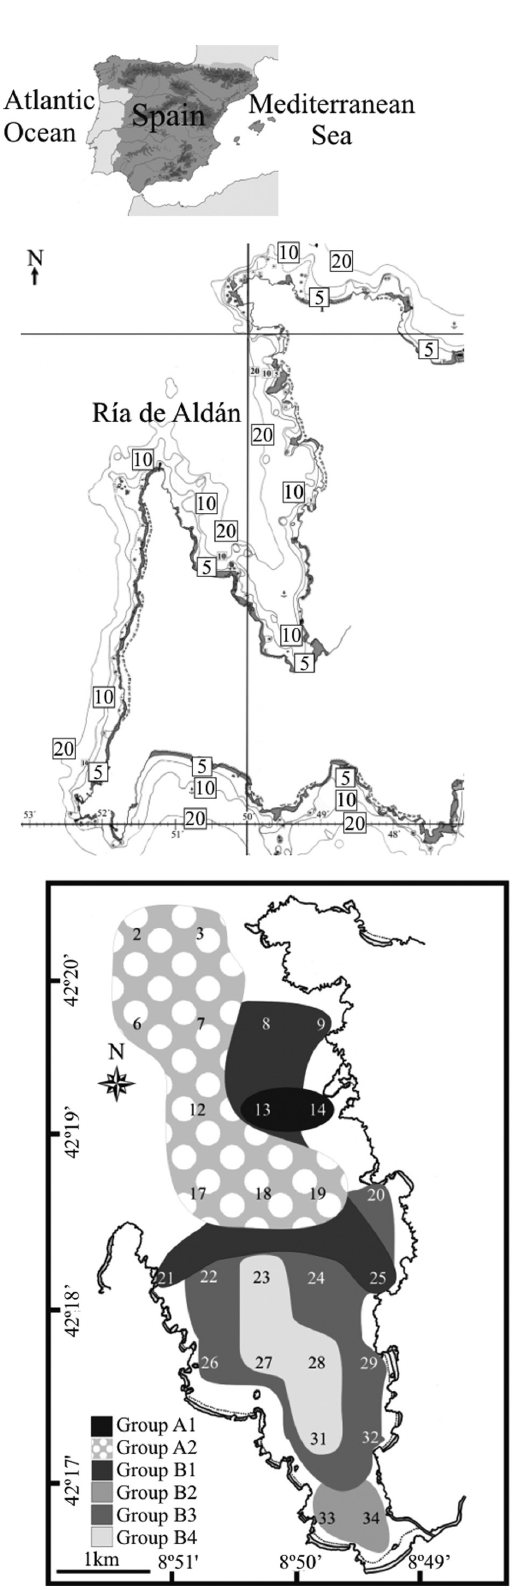
Fig . 1. – Location of the Ría de Aldán (Galicia, NW Spain), and position of the 27 sampling stations with the spatial distribution of faunal assemblages as determined by multivariate